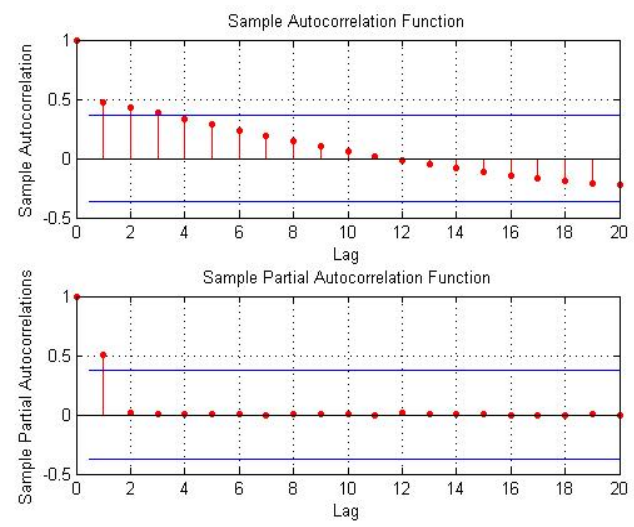
Fig. 2. ACF and PACF plots for Hindalco high returns series